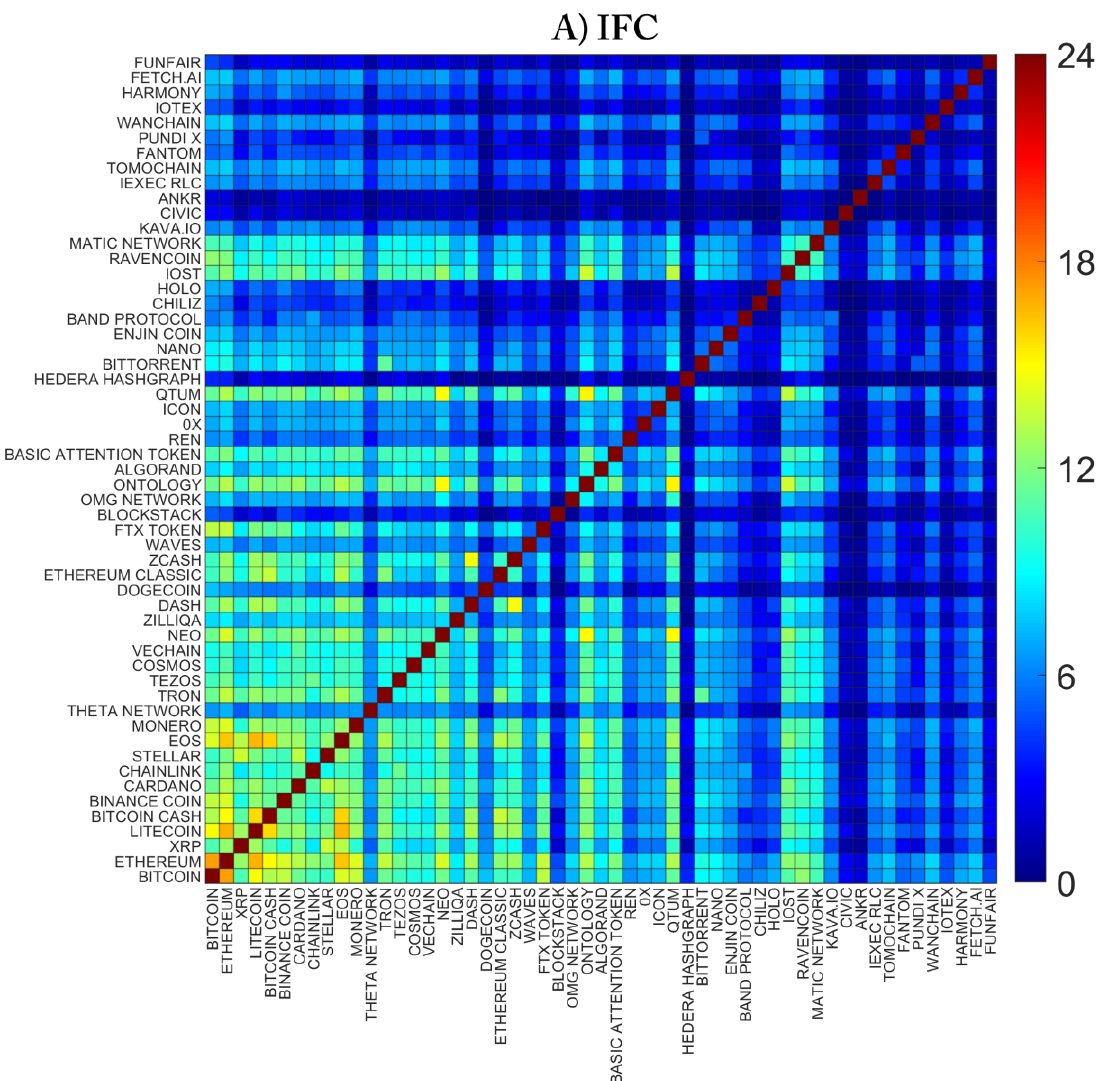
Fig. 2A. Total pairwise iso-frequency coupling (IFC). Each pixel value corresponds to the sum of all significant IFC values for each pair of